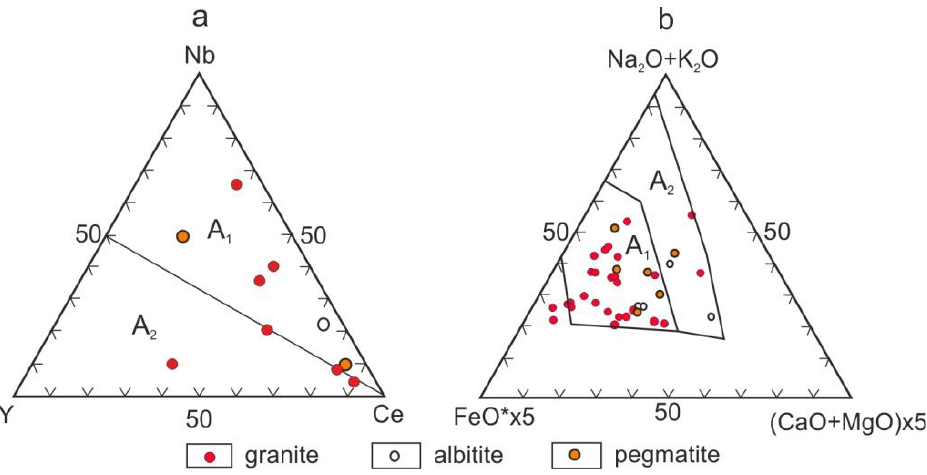
Figure 21. ( a ) Y – Nb – Ce and ( b ) (FeO* × 5) − (Na 2 O + K 2 O) − (CaO + MgO) × 5 diagrams for rocks of the Somnitelnyi massif and Tommot deposit . Fields in the diagrams: ( a ) A 1 — granitoids from rift, plume, and hotspot environments, A 2 — granitoids from postcollisional, postorogenic, and anorogenic envi- ronments [70]; ( b ) A 1 — silicic rocks of within-plate geodynamic settings: oceanic islands and conti- nental rifts; A 2 — felsic igneous rock associations of intracontinental- and continental-margin geody- namic settings [74].